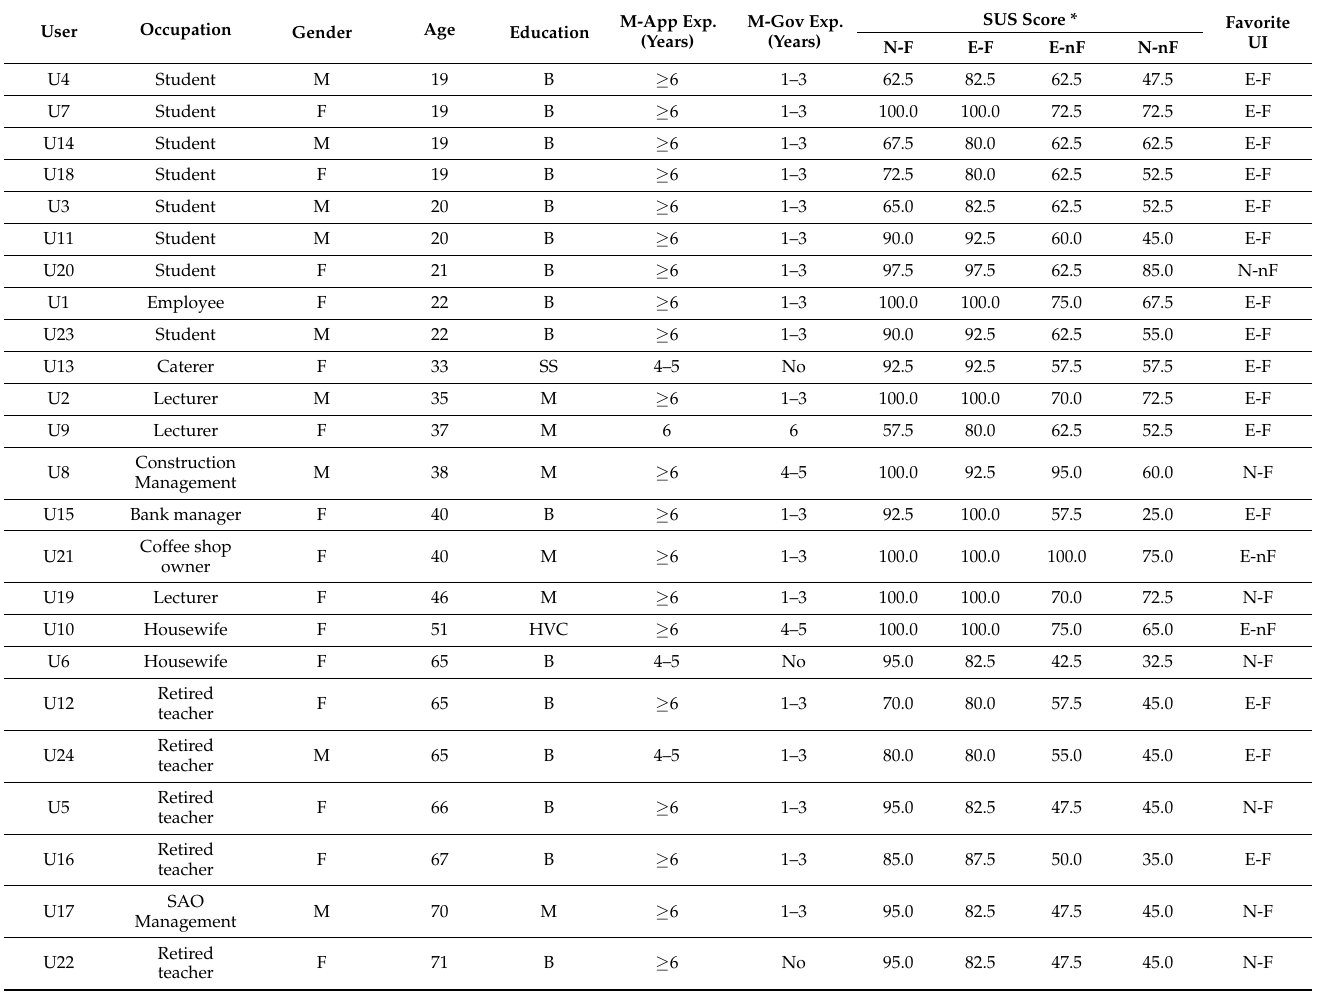
Table 13. Demographic information of 24 participants and SUS scores (ordered by